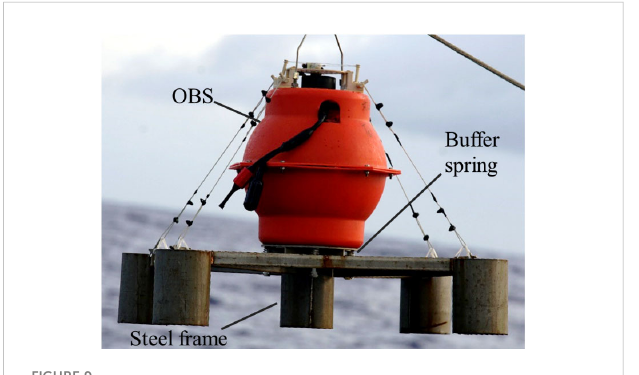
FIGURE 9 Traditional OBS structure (accessedhttp://oil.igg.cas.cn/gb2019/hddzy/ hddzyobs/, 2019).